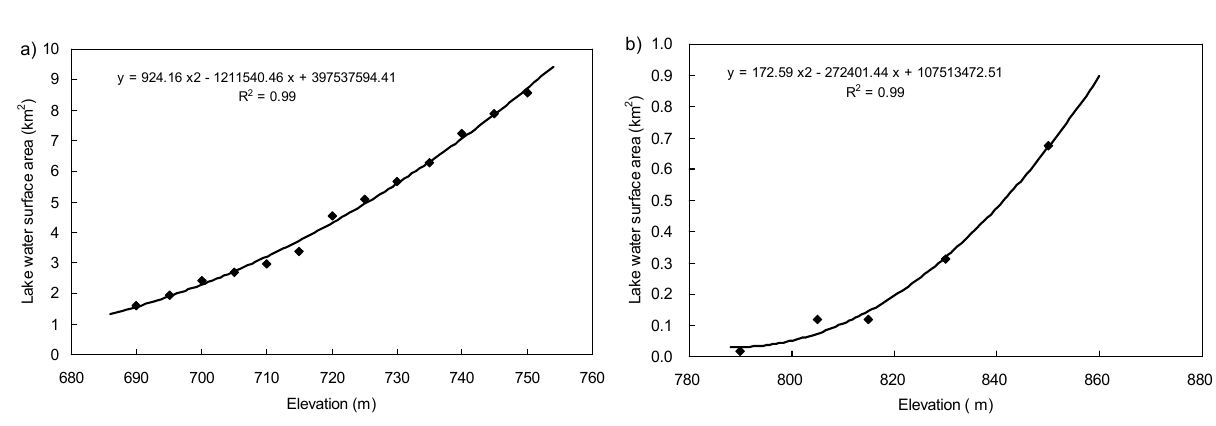
Fig. 8. Relationship between elevation and lake water surface area. ( a ) Tangjiashan Landslide Dam (data from Zhang et al. 2008); ( b ) Xiaogangjian Landslide Dam (data from Liu et al. 2009a).